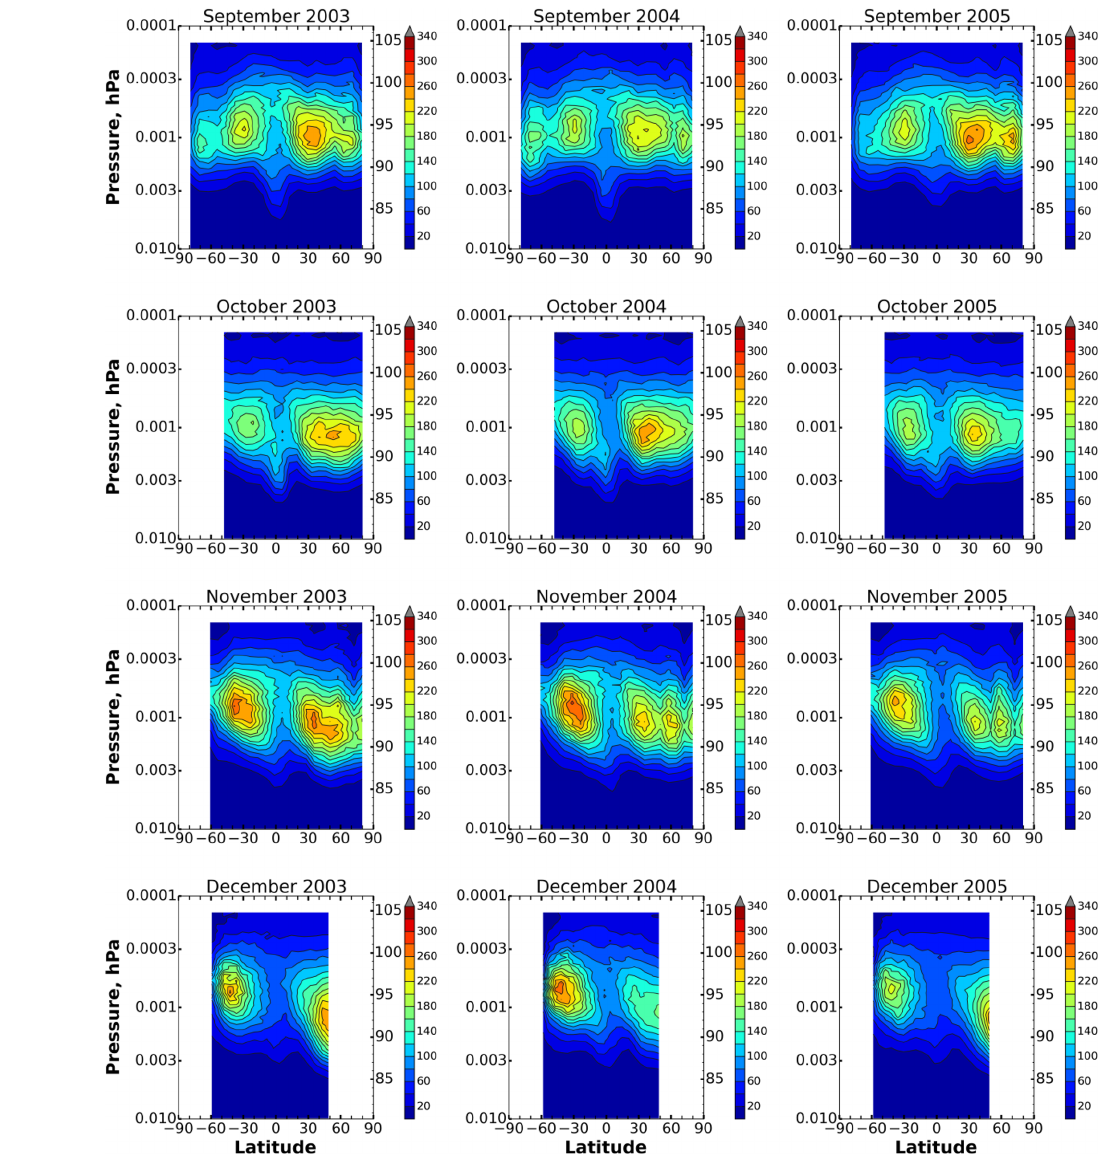
Figure 3. Monthly averaged O( 1 D) concentration (in cm − 3 ) in September–December of 2003–2005.